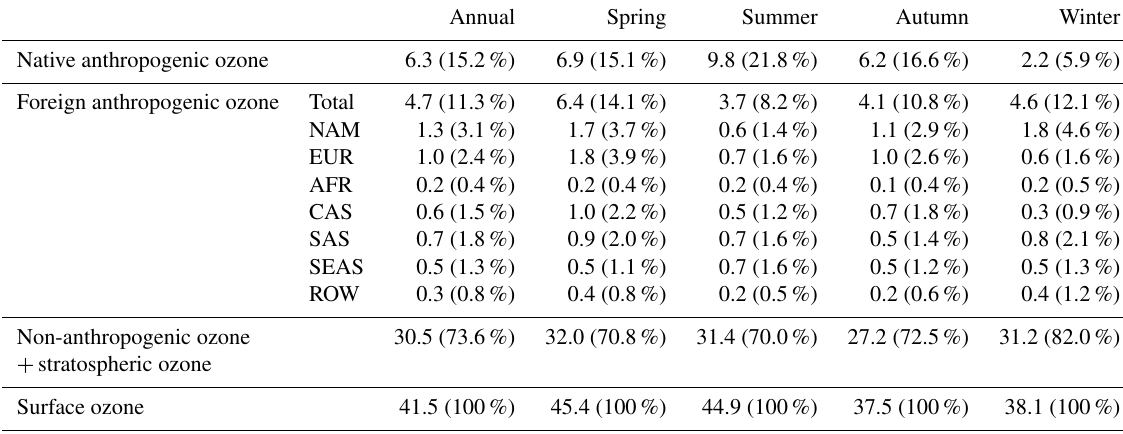
∗ All values are the means over East Asia. The abbreviations stand for different regions (Fig. 1): East Asia (EAS), North America (NAM), Europe (EUR), Africa (AFR), central Asia (CAS), South Asia (SAS), South-east Asia (SEAS), and the rest of the world (ROW). Total foreign anthropogenic ozone is the sum of the contributions from all foreign anthropogenic